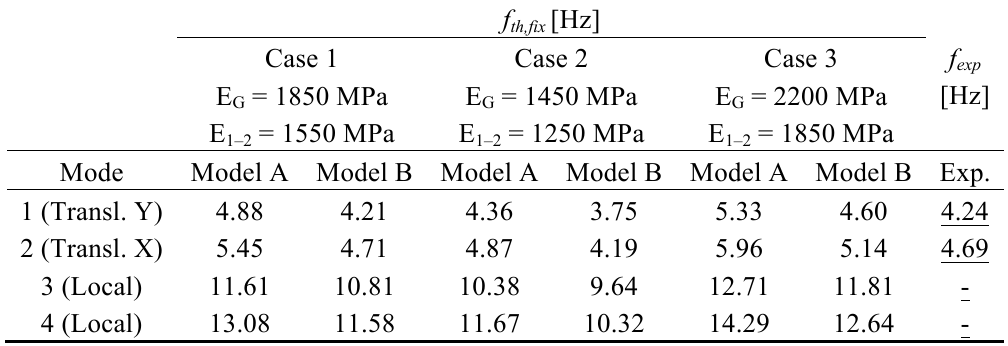
Table 3. Experimental and theoretical main frequencies of Palazzo Bosco for different values of Young’s modulus of masonry, E, in the case of fixed